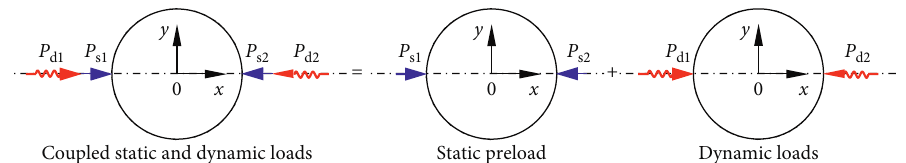
Figure 2: Stress analysis diagram of the disk specimen under coupled static and dynamic